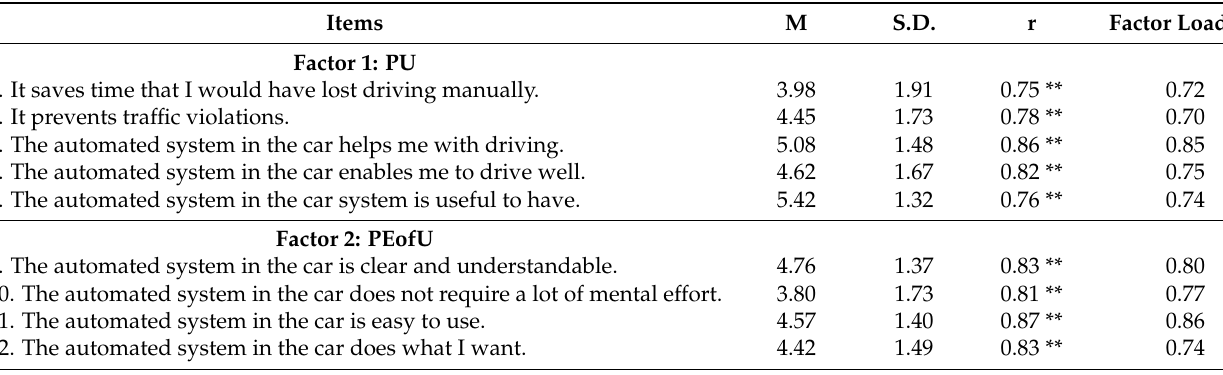
Table 6. TAM factor structure and factor